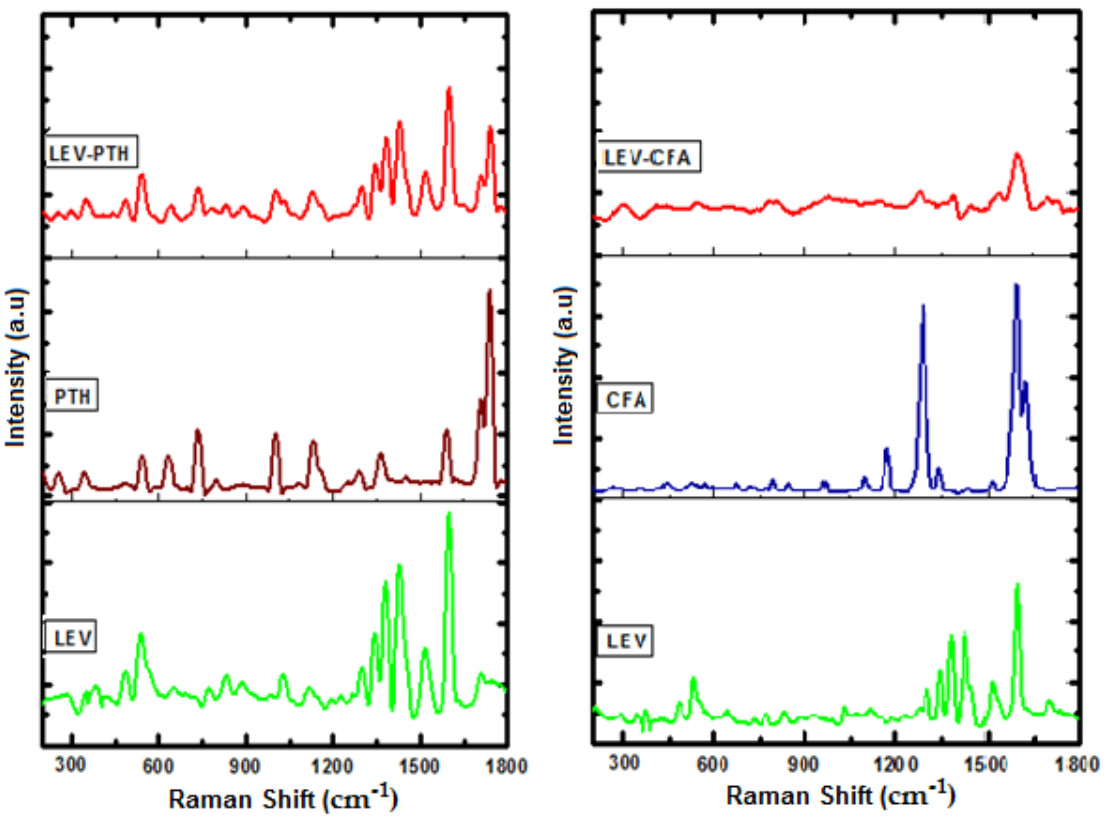
Figure 3. Raman spectra of cocrystal (LEV-PTH), amorphous salt (LEV-CFA) and respective pure components wave number range (200 – 1800 cm −1 ).